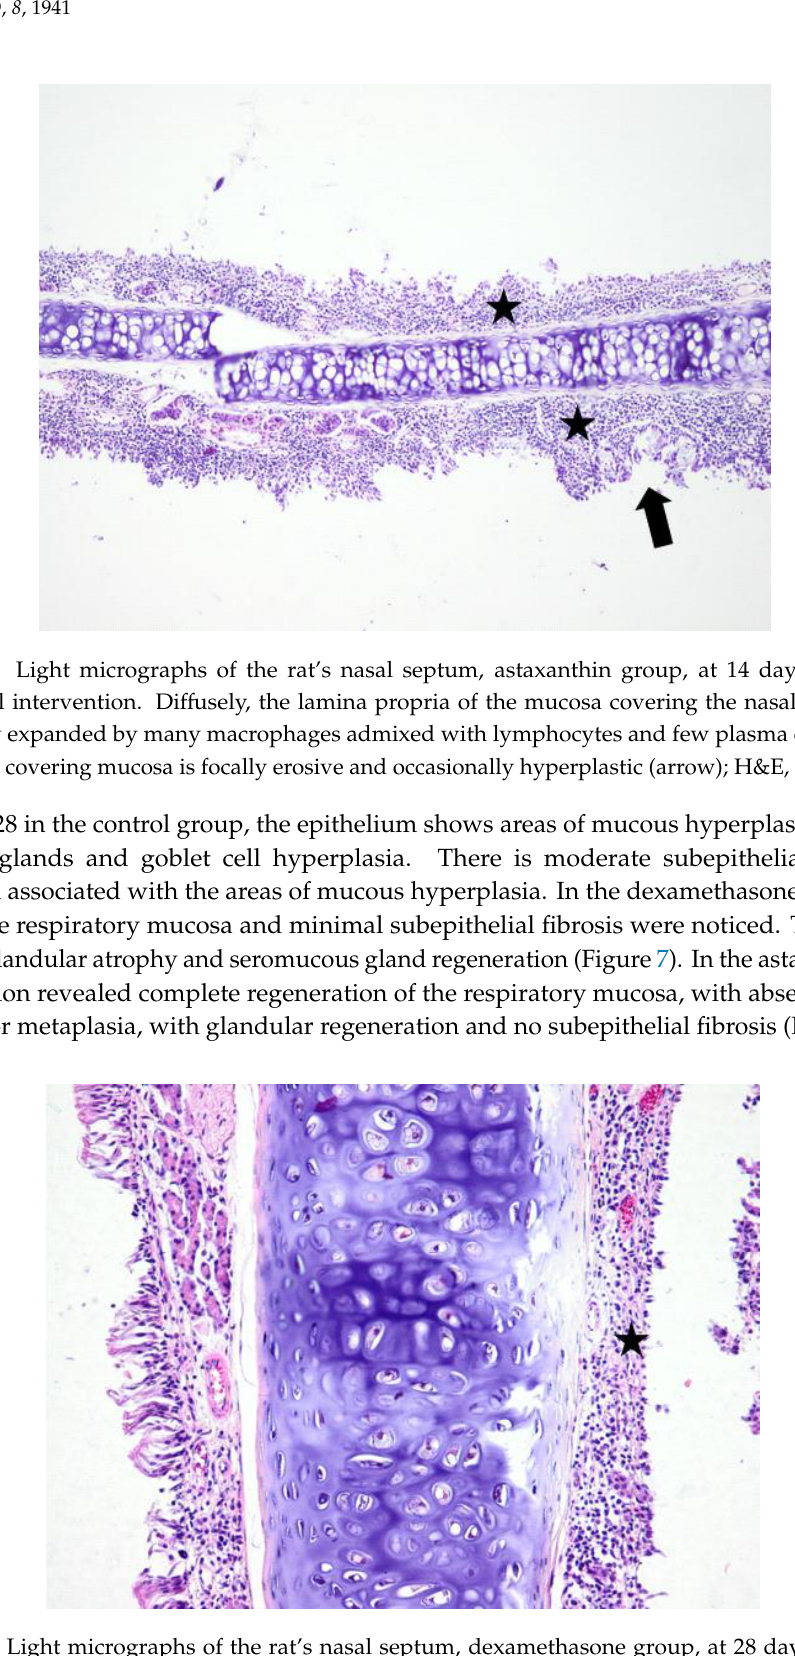
Figure 7. Light micrographs of the rat’s nasal septum, dexamethasone group, at 28 days after the intranasal intervention. Unilaterally the lamina propria of the mucosa covering the nasal septum is moderately expanded and the nasal glands are replaced by lymphocytes, macrophages and plasma cells (black star). The covering mucosa is focally erosive; H&E, ob ×20.